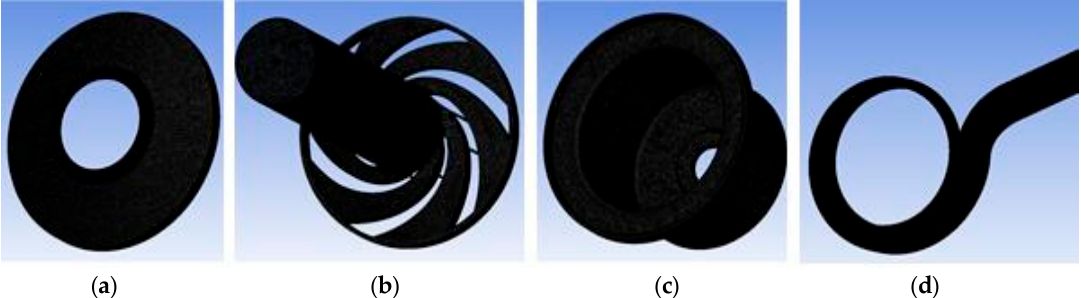
Figure 4. Meshes created for the computational fluid dynamics (CFD) analysis of the pump model with Type A balancing holes.